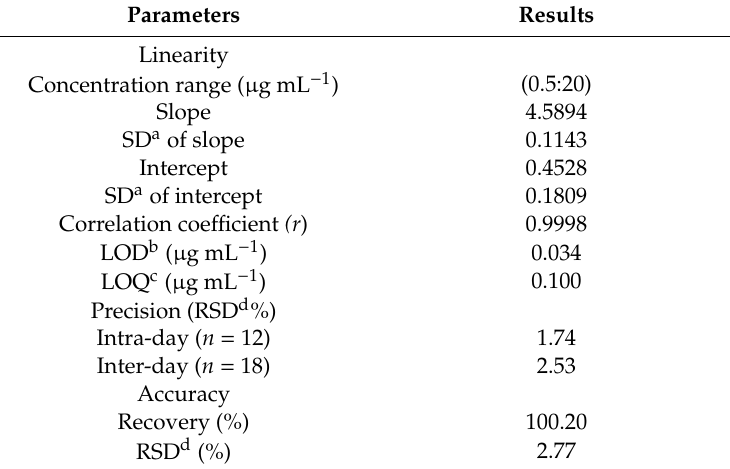
Table 1. Validation results of the developed method with diode array detection (DAD)